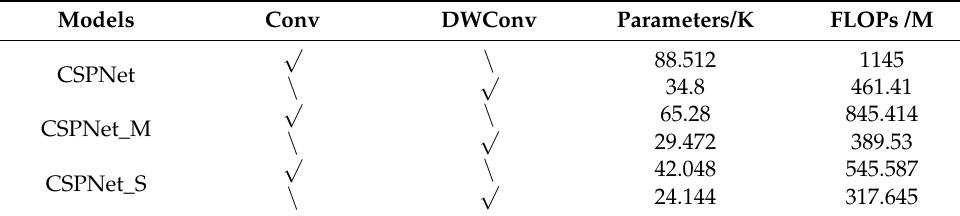
Figure 4. Three CSPNet Structures. Table 3. Three different network model sizes based on CSPNet